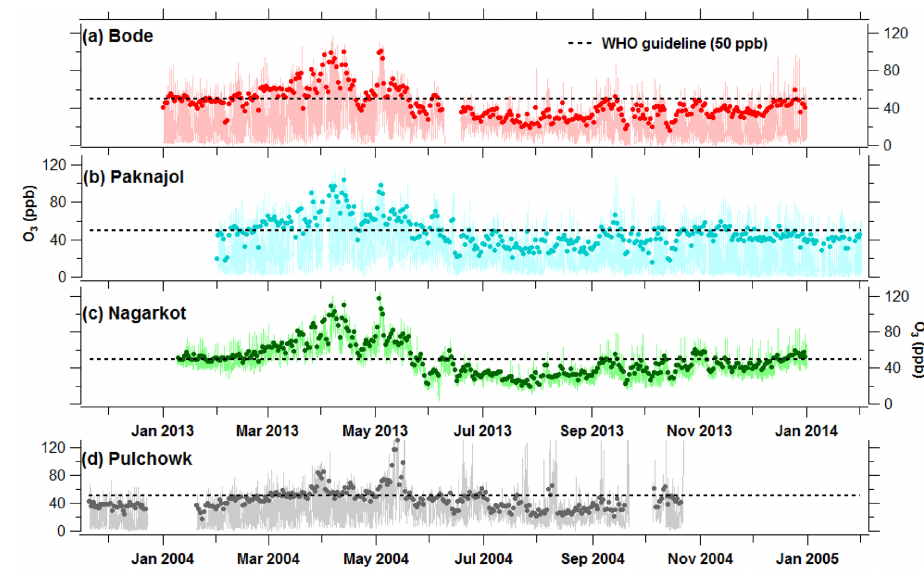
Figure 6. Time series of hourly average (faint-colored line) and daily maximum 8h average (solid-colored circle) O 3 mixing ratio at (a) Bode (semiurban), (b) Paknajol (urban) and (c) Nagarkot (hilltop) observed during 2013–2014, and (d) Pulchowk (urban) observed during Novem- ber 2003–October 2004 in the Kathmandu Valley. Black dotted line represents WHO guideline (50ppb) for daily maximum 8h average of O 3